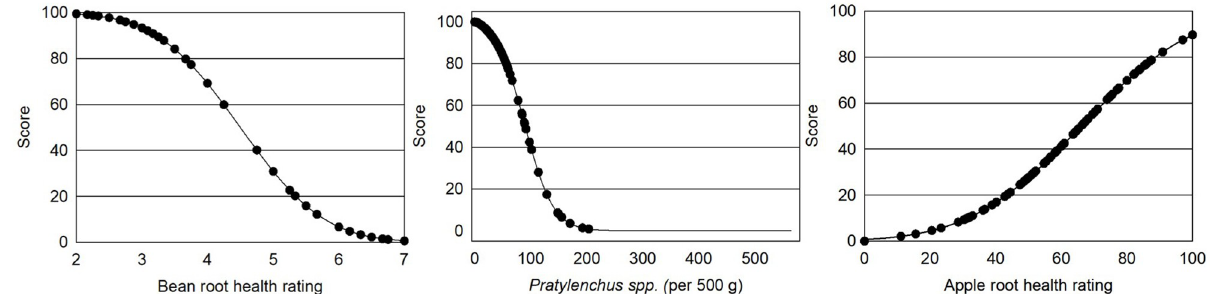
Fig 2. Indicators measuring the root health function of soil including bean root health rating, numbers of Pratylenchus penetrans nematodes, and apple root health rating.